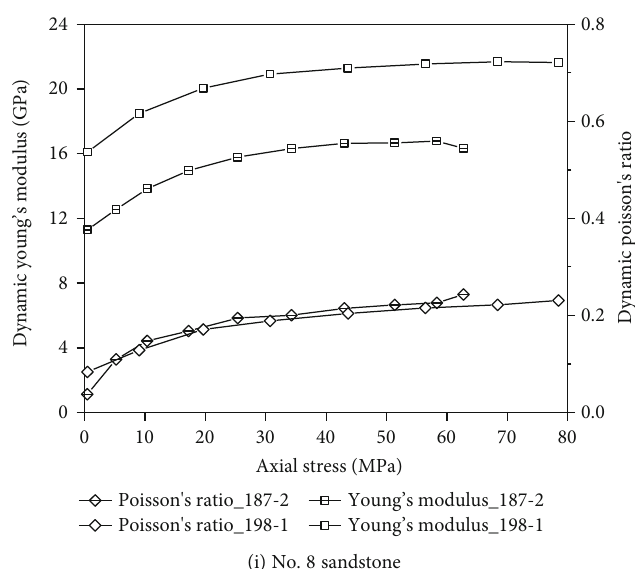
Figure 12: Variation of Young ’ s modulus and Poisson ’ s ratio during loading.